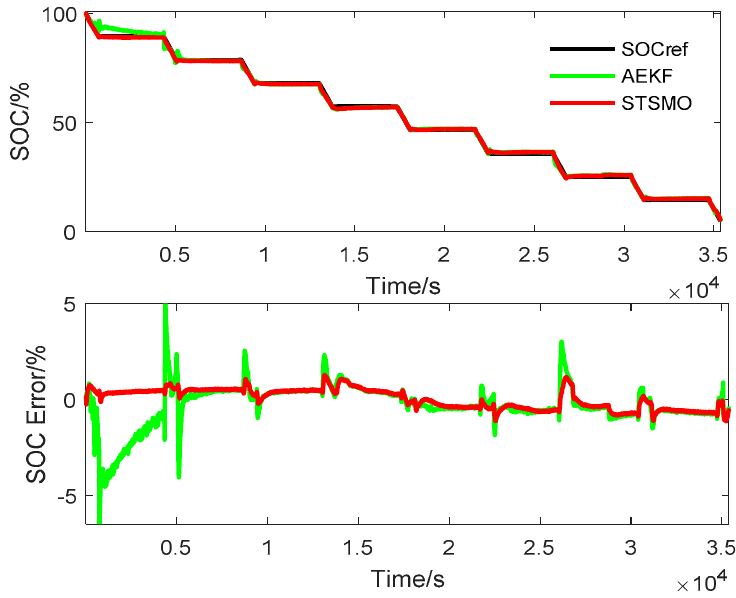
Figure 15. SOC estimation for 0.5 C pulse current discharge (PCD) profile.